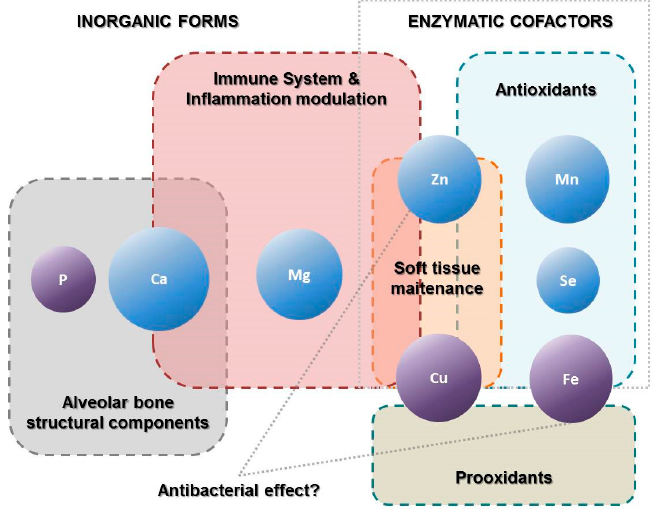
Figure 2. Role of minerals with possible implications in periodontal disease pathogenesis.